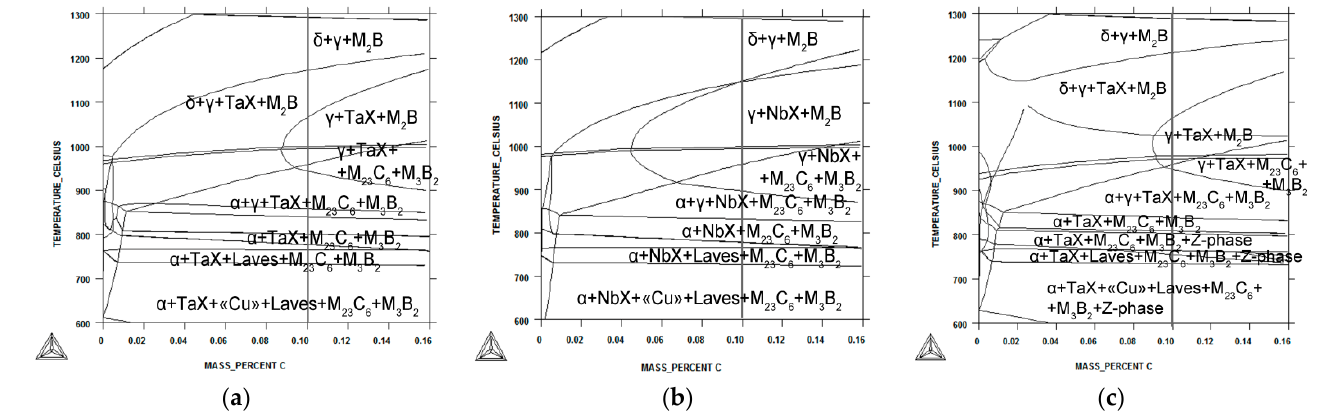
Figure 5. Phase diagram via Thermo-Calc software for the 12CrTaNb0.003N ( a ), 12CrNb0.003N ( b ), and 12CrTaNb0.02N ( c ) steels. Table 6. The temperatures of equilibrium phase transformation for the 12% Cr steels studied.